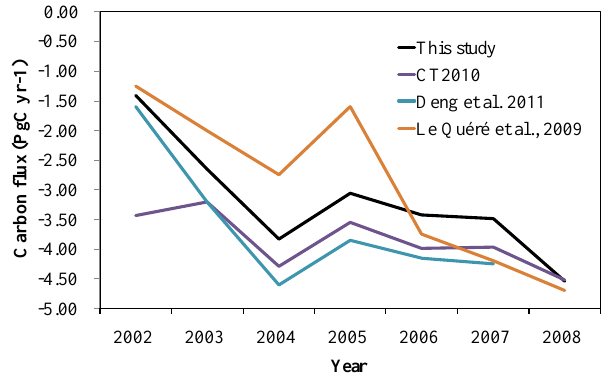
Fig. 4. Inter-annual variation of global terrestrial ecosystem carbon sinks (2002–2008).